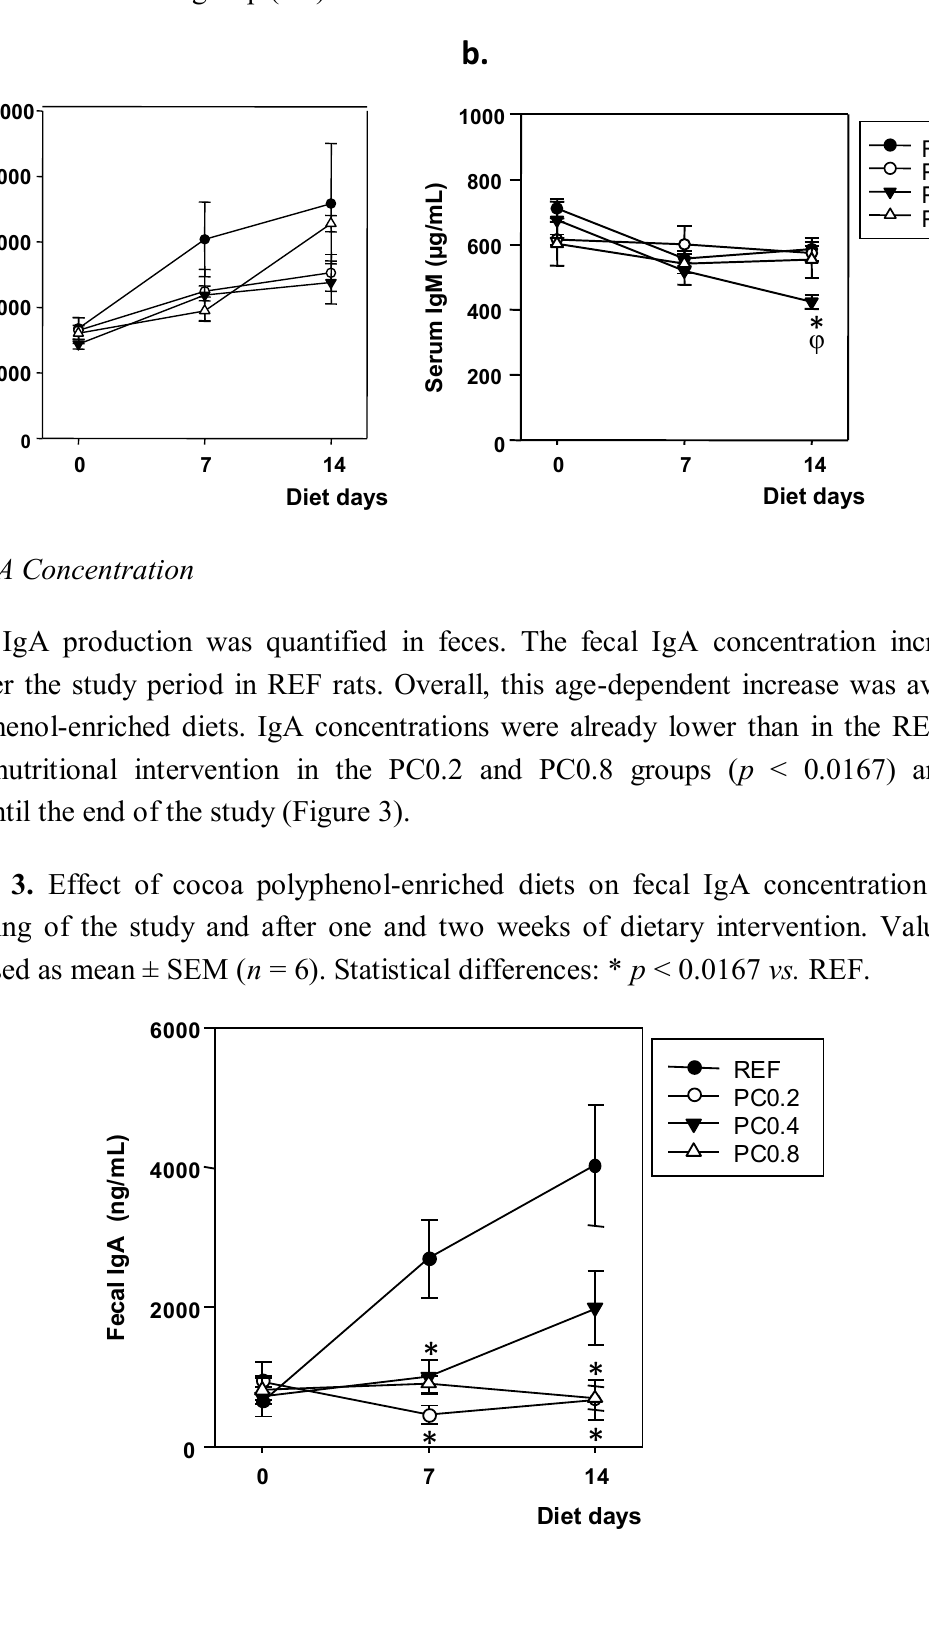
Figure 2. Effects of cocoa polyphenol-enriched diets on serum IgG ( a ) and IgM ( b ) concentrations at the beginning, and after one and two weeks of diet. Values are expressed as mean ± SEM ( n = 6). Statistical differences: * p < 0.0167 vs. REF and φ p < 0.0167 vs. cocoa group (PC)0.2.